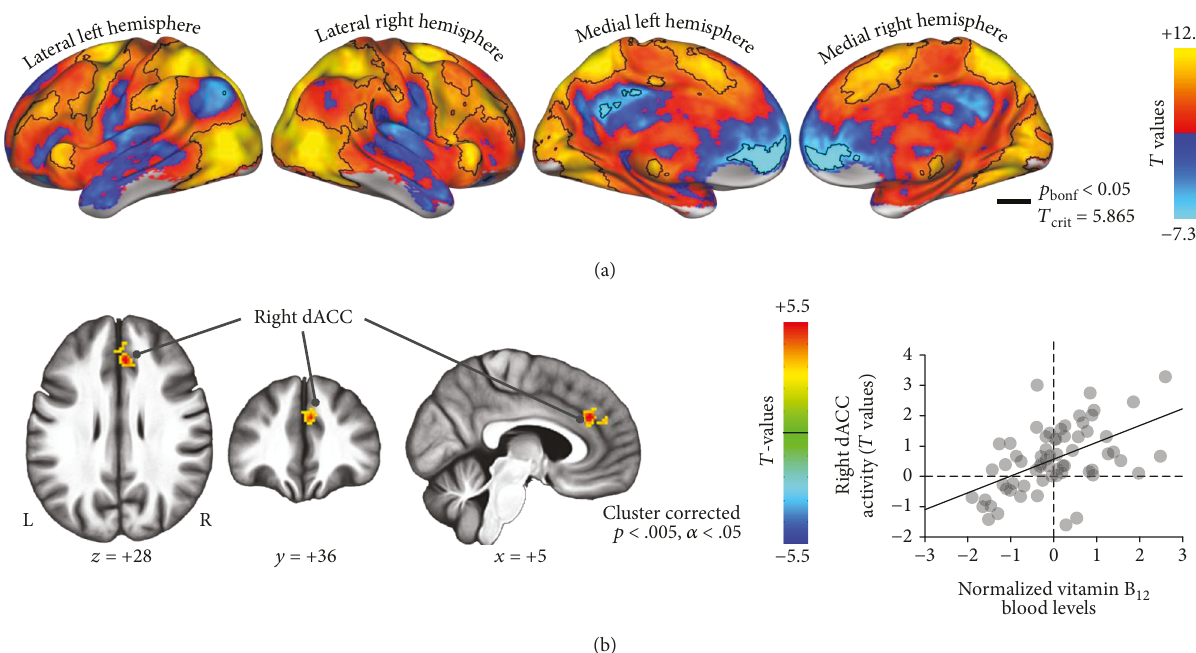
Figure 3: Brain activity results. (a) fMRI task-evoked activity across subjects entails medial and lateral occipital regions (i.e., primary and motion-sensitive visual cortex), the dorsal parietal attention network (intraparietal sulcus and superior parietal lobule), frontal areas involved in motor control and focusing (ventral and dorsal premotor, as well as the supplementary motor), and nodes of the salience network (e.g., anterior insula). Regions enclosed in black survived the Bonferroni correction for multiple comparisons ( p value < 0 05 ). (b) Results for the relationship between biochemical markers and task-evoked brain activity. Hemodynamic activity of the right dorsal anterior cingulate cortex (dACC), located within the task-positive network, was found to be signi fi cantly associated with B concentrations (two-tailed p value < 0 005 for the cluster-forming threshold and α < 0 05 for cluster signi fi